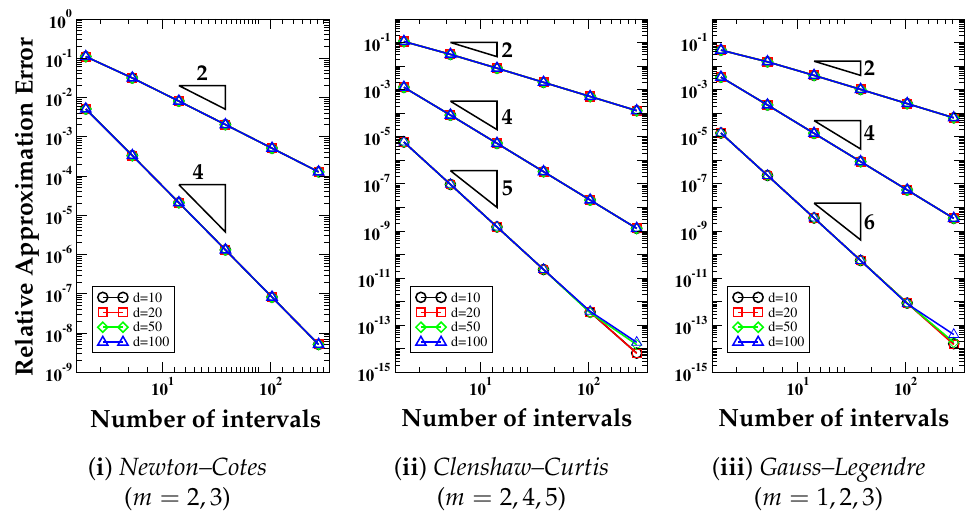
Figure 2. Test Case 1. Relative approximation error curves versus the number of intervals per direction N for the numerical integration of a d -dimensional polynomial of degree 10, d = 10,20,50,100, using ( i ) Newton–Cotes formulas (trapezoidal and Simpson quadrature rules); ( ii ) Clenshaw–Curtis formula with m = 2,4,5; ( iii ) Gauss–Legendre formulas with m = 1,2,3. The expected convergence rate is shown by the number close to the triangular shapes and is proportional to N − 2 (trapezoidal rule); N − 4 (Simpson rule); N − m (Clenshaw–Curtis rule); N − 2 m (Gauss–Legendre